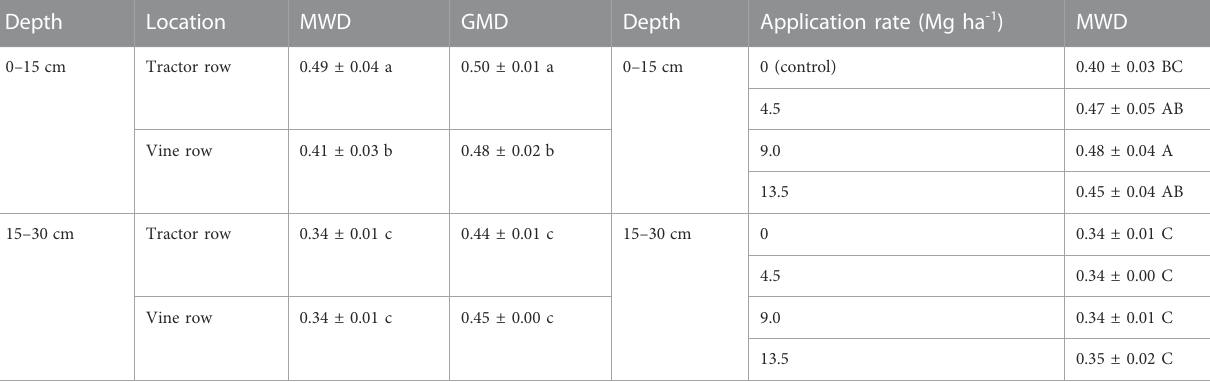
TABLE 3 Mean weight diameter (MWD) and geometric mean diameter (GMD) of soil aggregates, and the respective standard errors of means (n = 4) by functional location and depth (left), and by compost application rate and depth (right, shaded) in April 2020. Lowercase letters indicate signi fi cant differences between depths and locations, uppercase letters indicate signi fi cant differences between depth and